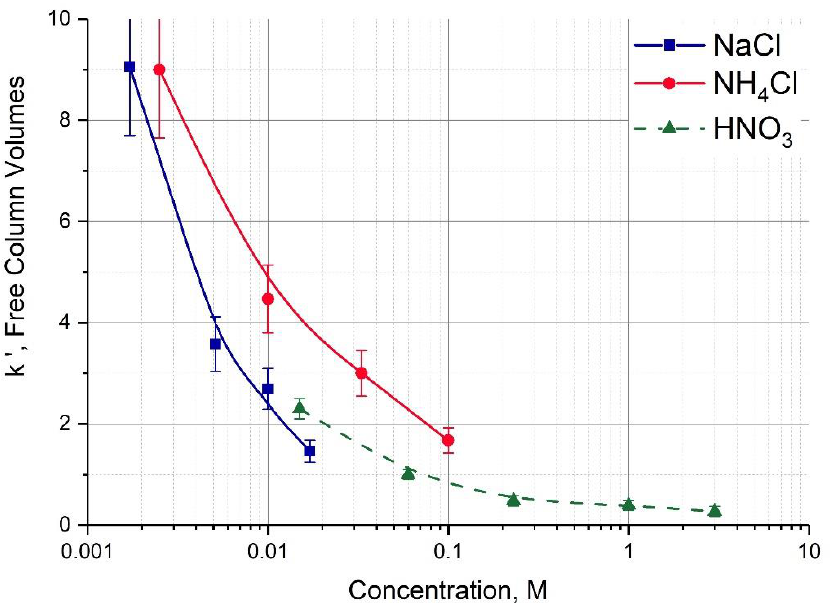
Figure 3. The capacity factor k’ of Fr(I) upon sorption onto Actinide Resin as a function of NaCl and NH 4 Cl concentrations. The literature data [30] for HNO 3 solutions are shown by dotted line.